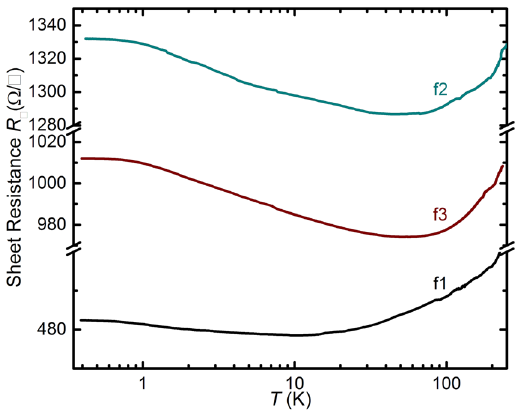
vs T at B = 0 for films f1, f2 and f3 (films as indicated). □